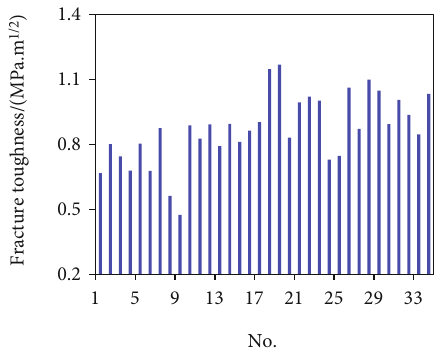
Figure 7: The fracture toughness of